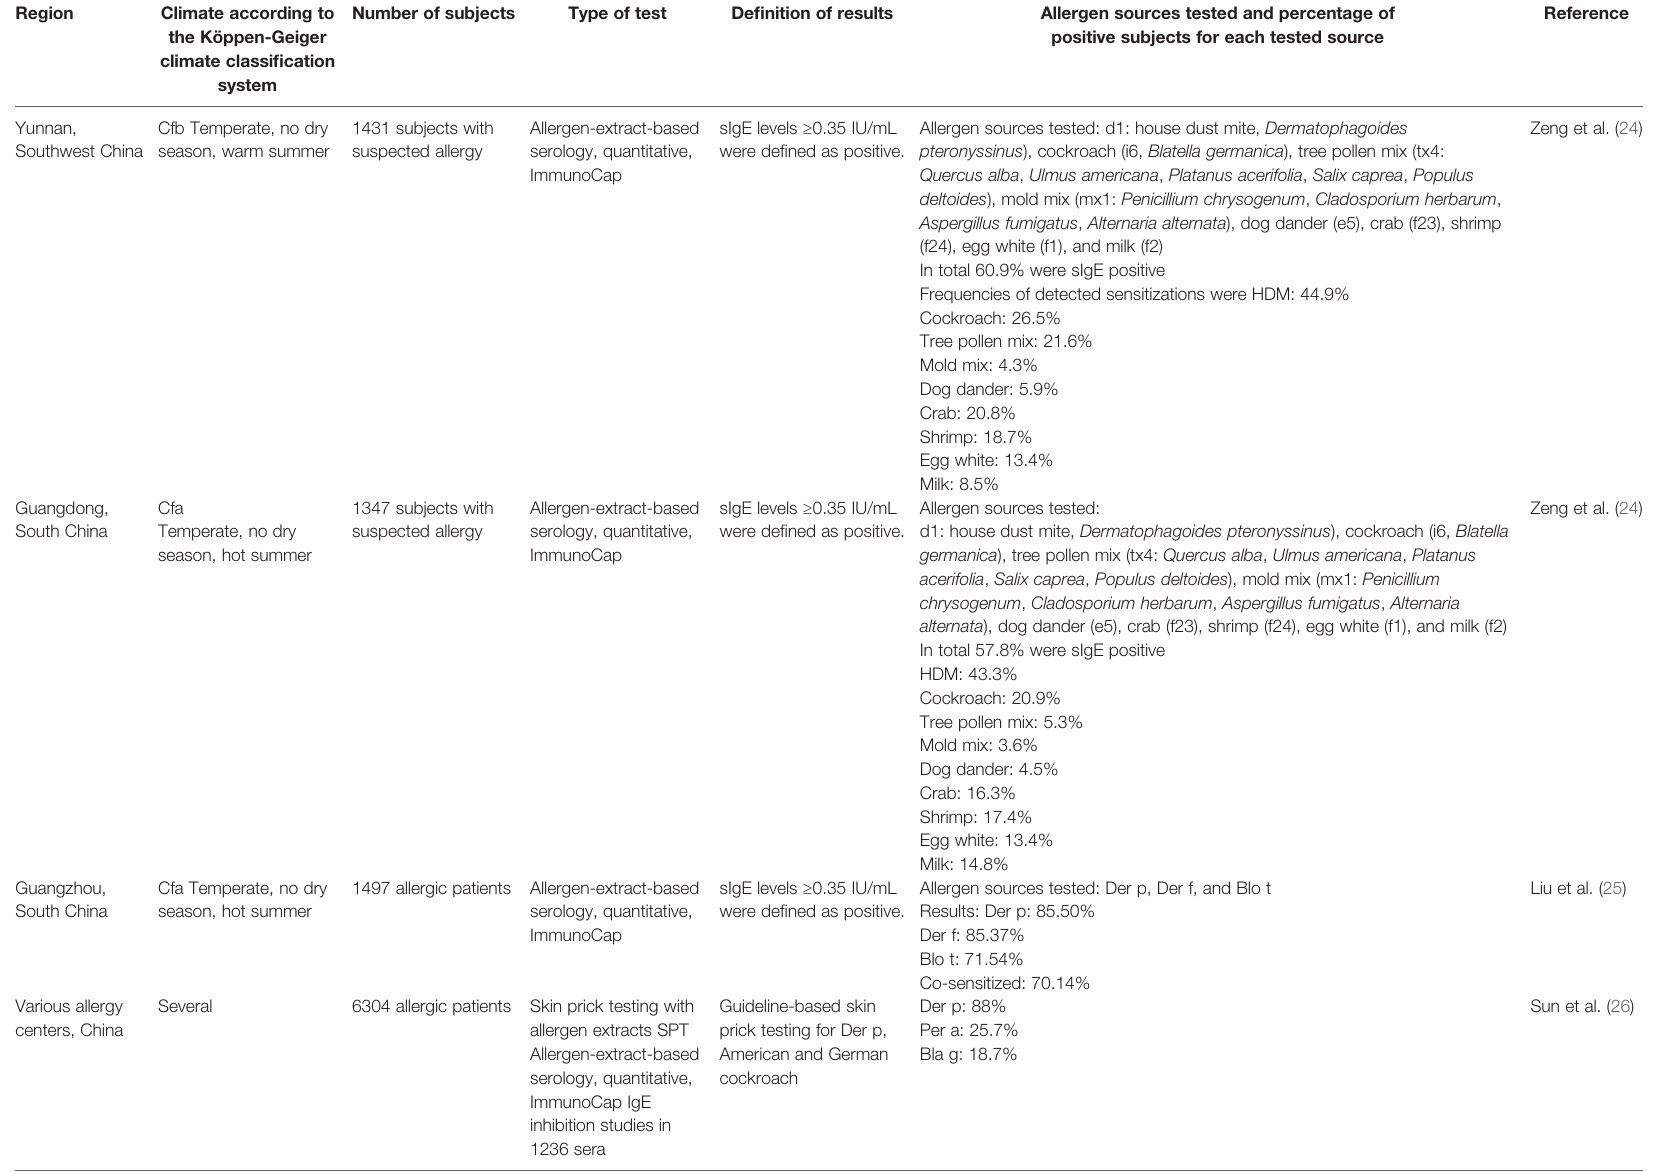
TABLE 2 | Allergen-speci fi c IgE sensitization in China according to questionnaire or allergen extract-based diagnosis.